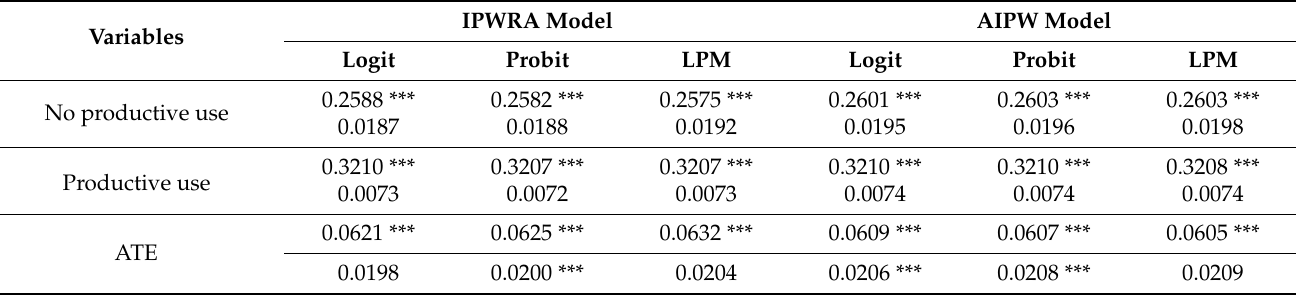
Table 5. The predicted probability of adoption of soil testing and formulated fertilization technology from double robust